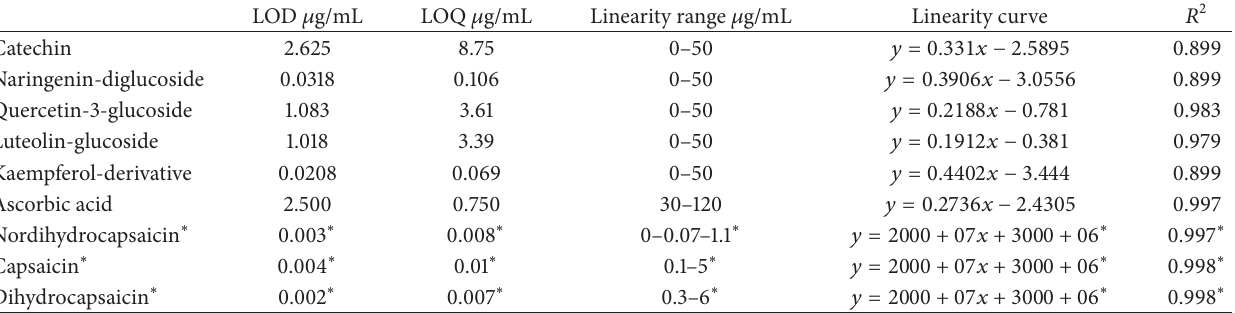
Table 1: Some validation parameters for the HPLC determinations of the major polyphenols, ascorbic acid, and capsaicinoids. LOD 𝜇 g/mL